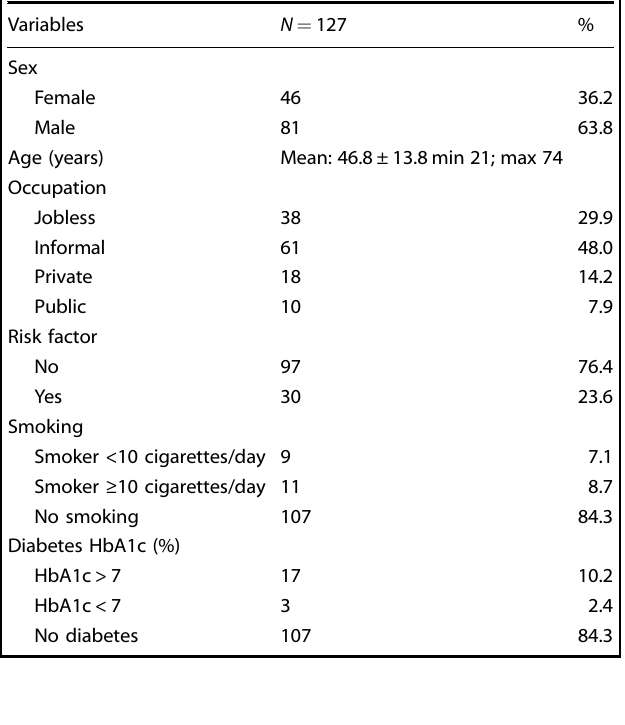
Table 3. Socio-demographic